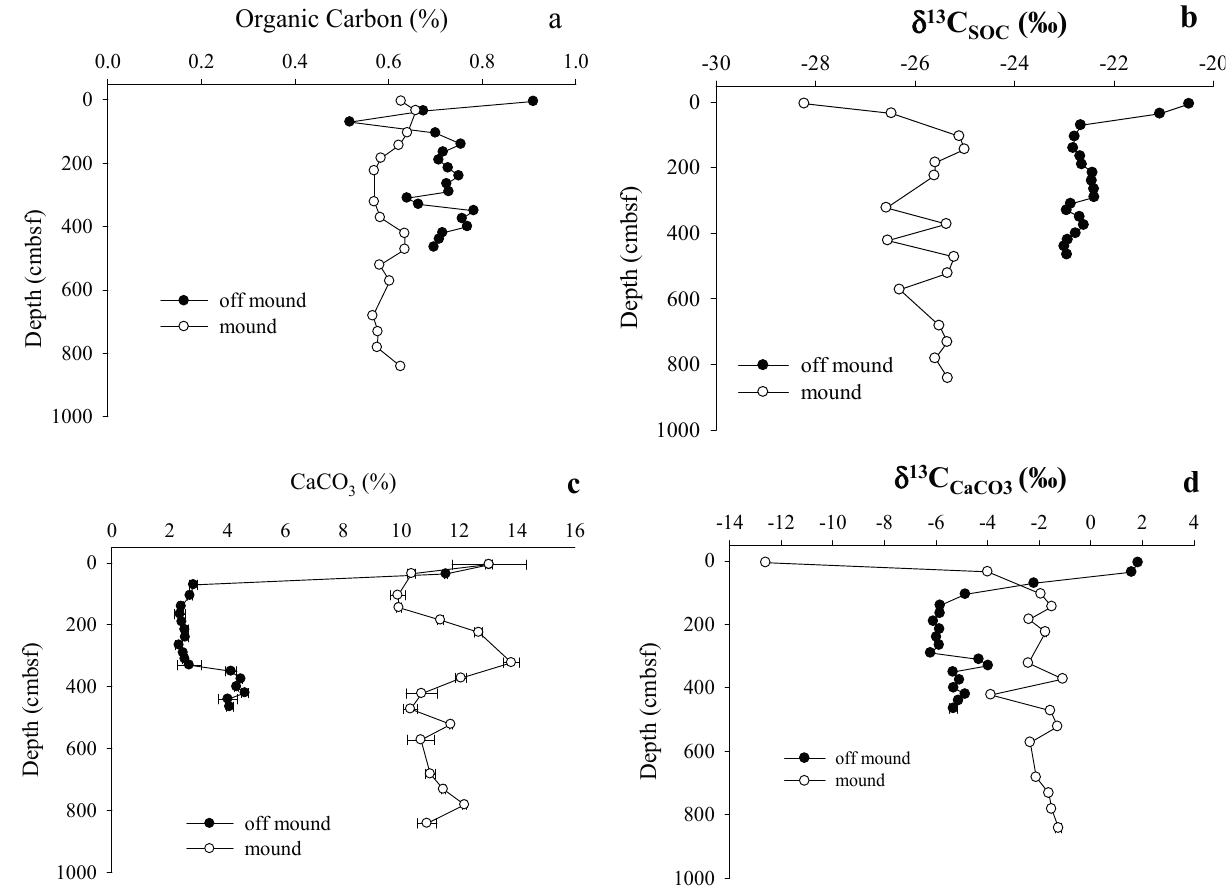
Figure 4. Sediment profiles at on-mound and off-mound sites: ( a ) Percent sediment organic carbon (SOC); ( b ) δ 13 C SOC ; ( c ) percent CaCO 3; and ( d ) δ 13 C CaCO